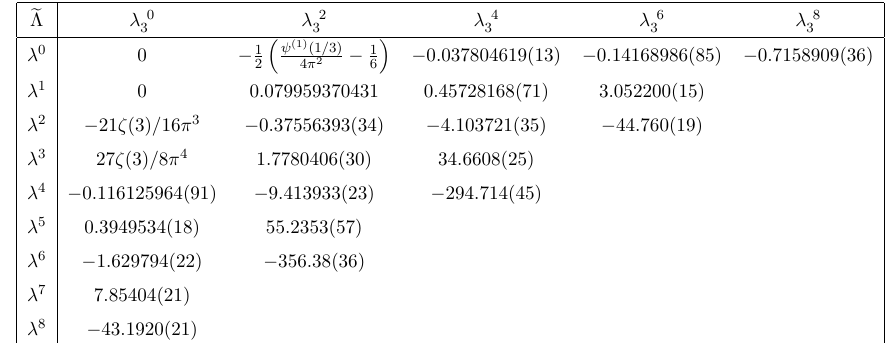
Table 6 . Perturbative coe(cid:14)cients for the vacuum energy